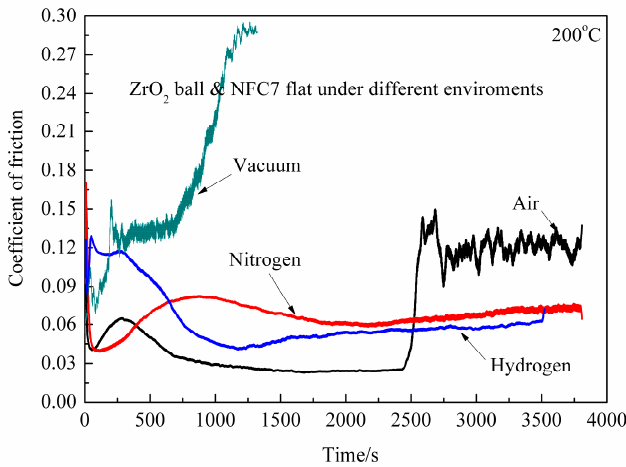
Figure 4. COF of ZrO 2 ball/DLC films under different environments at 200 °C.